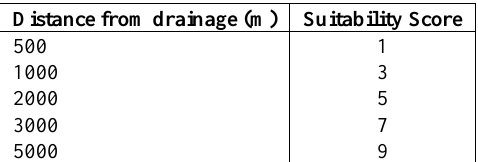
Table 8. Suitability Scores given for drainage